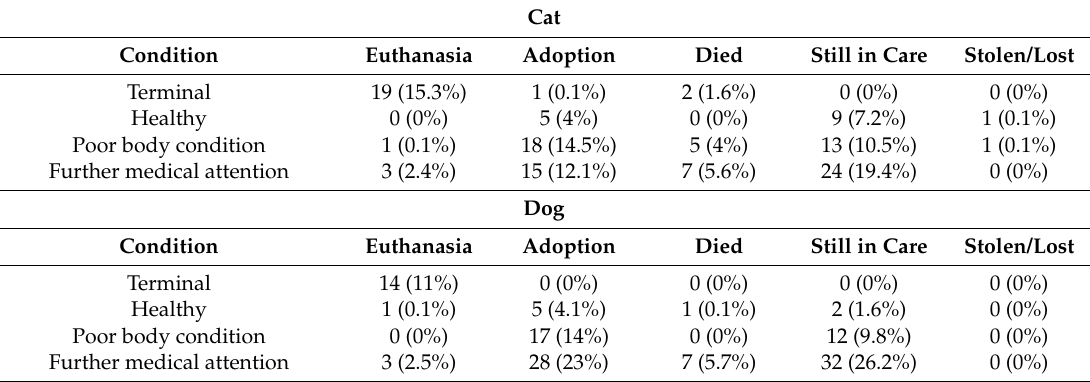
Table 6. Summary of actual numbers ( n = 124 cats and 122 dogs) and percent of total sample of condition at intake for cats and